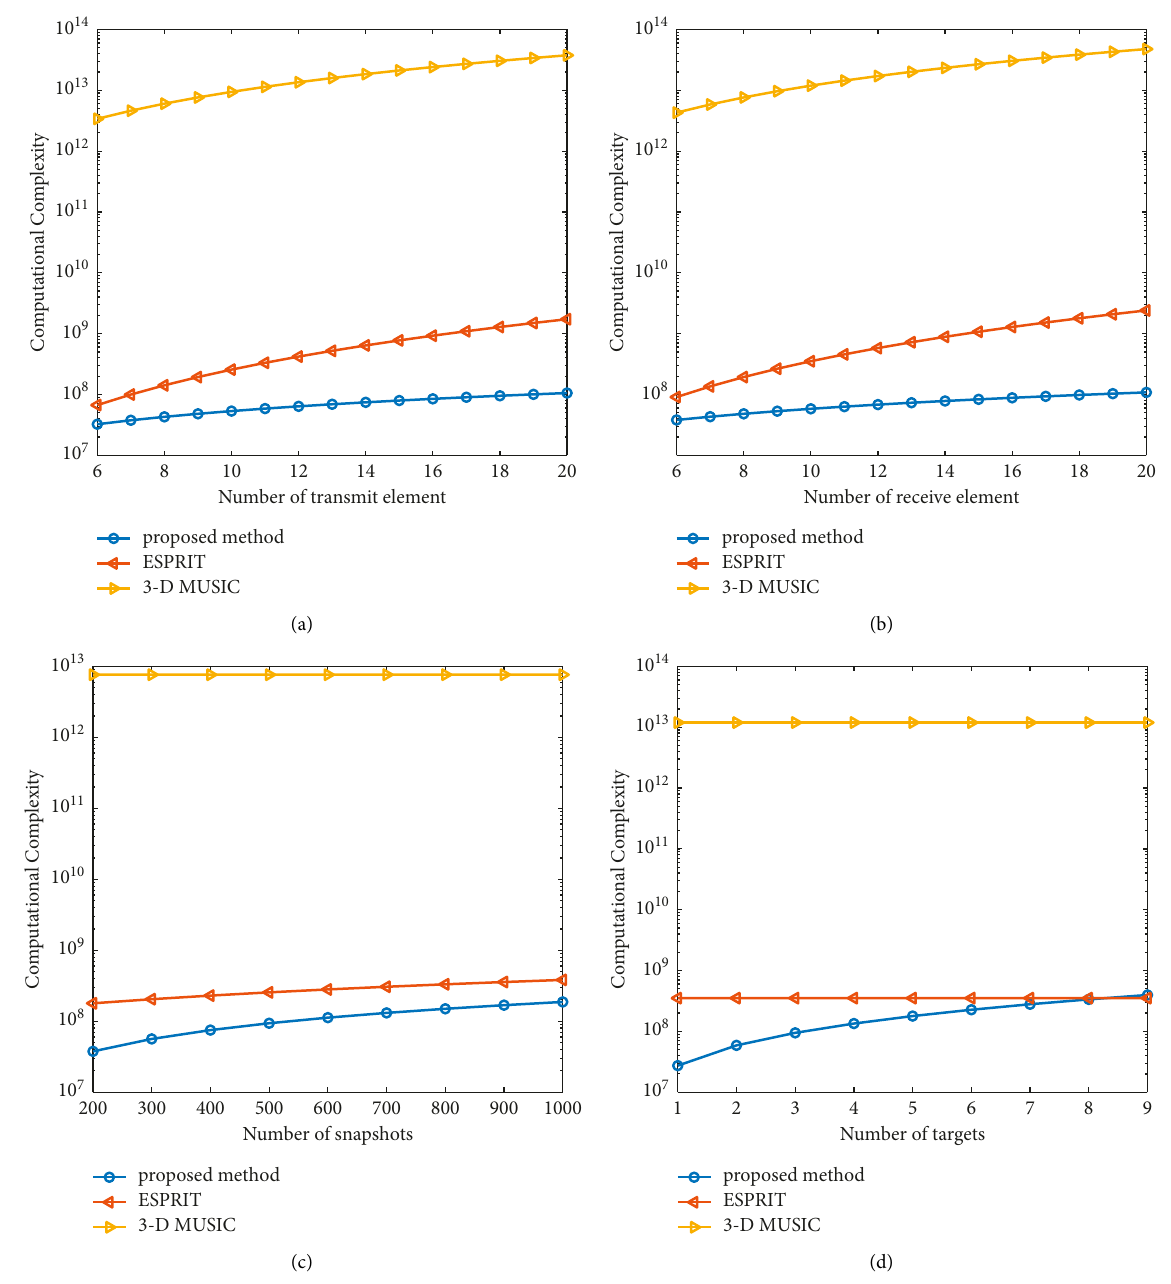
Figure 5: The computational complexity among different algorithms. (a) Complexity versus the number of transmit elements, (b) complexity versus the number of receive elements, (c) complexity versus the number of snapshots, and (d) complexity versus the number of